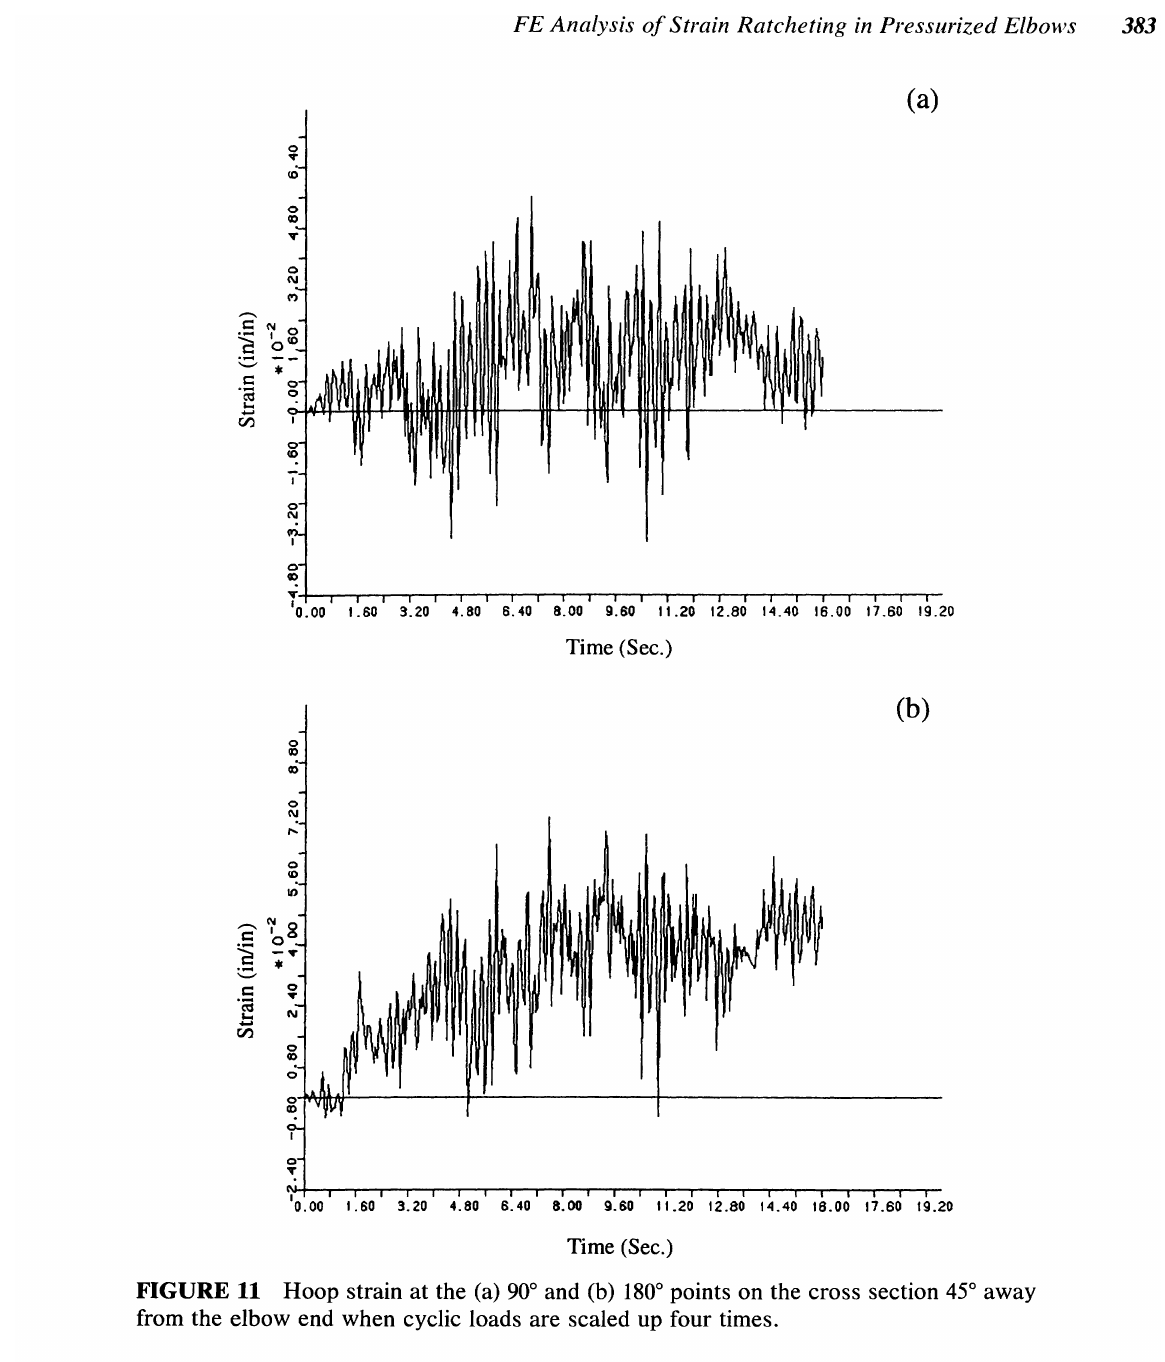
FIGURE 11 Hoop strain at the (a) 90° and (b) 180° points on the cross section 45° away from the elbow end when cyclic loads are scaled up four